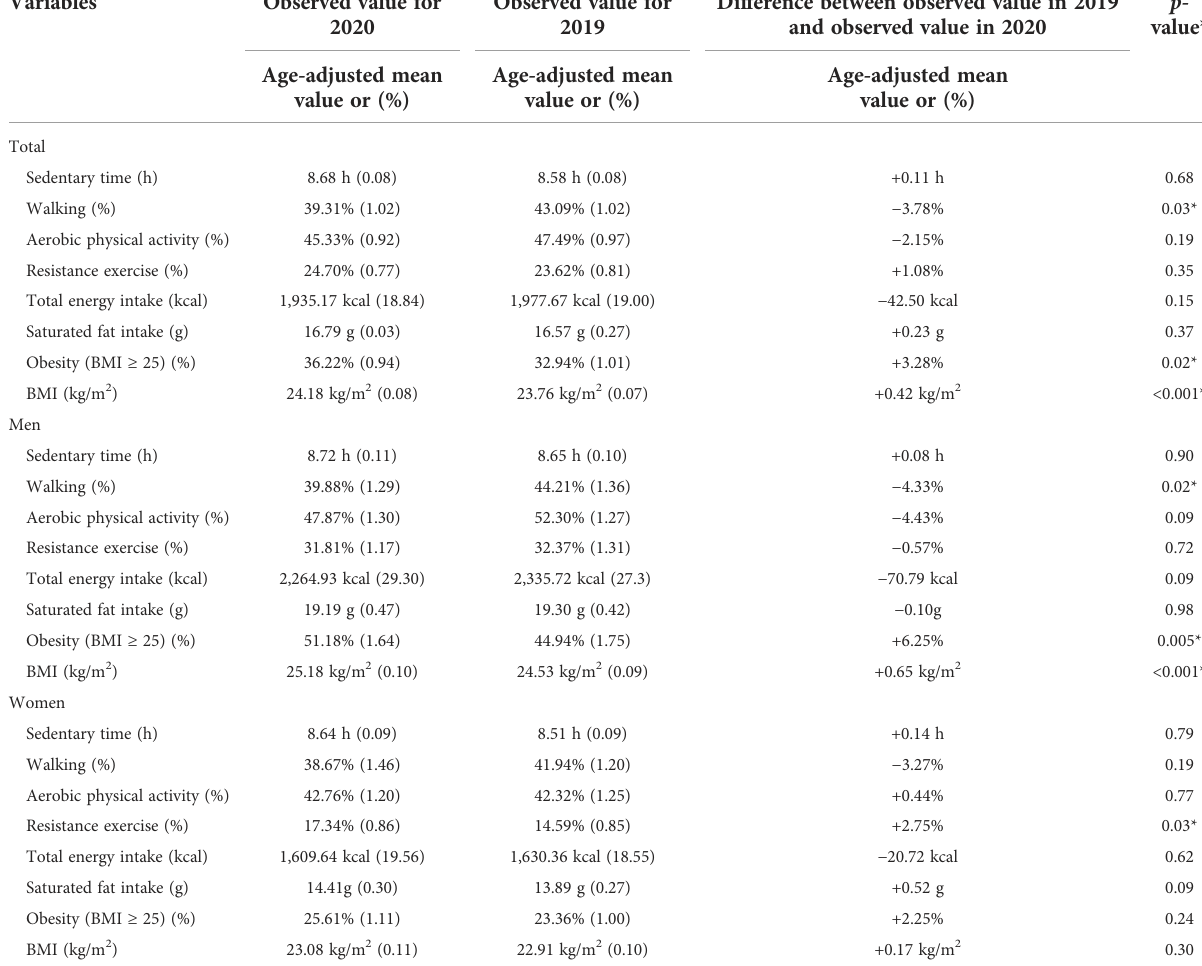
TABLE 2 Difference in age-standardized rates for physical activity, nutrient intake, and obesity between 2019 and 2020.